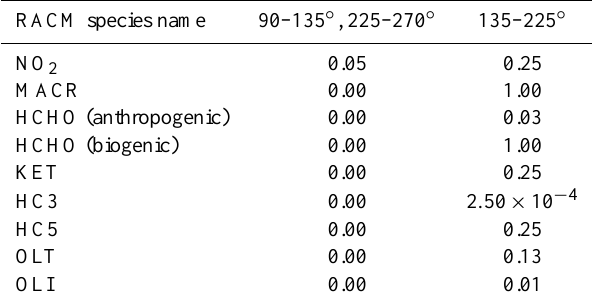
Table 2. Advection rates for NO x , VOC, and other hydrocarbons as a function of wind direction. Rates (in ppbvh − 1 ) are scaled by the geostrophic wind